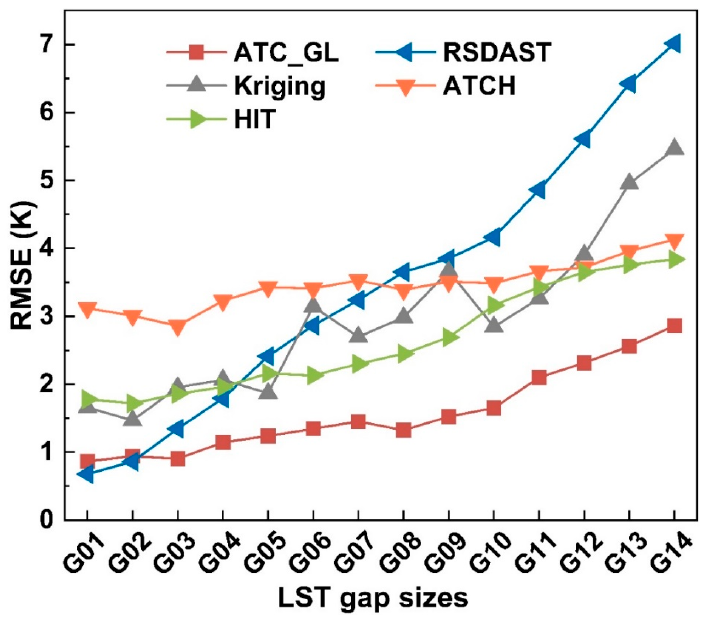
Figure 9. The performance of different methods according to LST gap size. G01 (10 × 10) –G14 (500 × 500) denote different LST gap sizes, including 10 × 10, 20 × 20, 30 × 30, 40 × 40, 50 × 50, 60 × 60, 70 × 70, 80 × 80, 90 × 90, 100 × 100, 200 × 200, 300 × 300, 400 × 400, and 500 × 500 (pixels or km 2 ). Compared to the other models, the ATC_GL had the highest accuracy (RMSE = 1.7 K) and preserved the best spatial detail at the largest LST gap size (500 × 500 pixels; Figure 10). The RSDAST (RMSE = 3.0 K) and Kriging interpolation (RMSE = 3.4 K) showed the